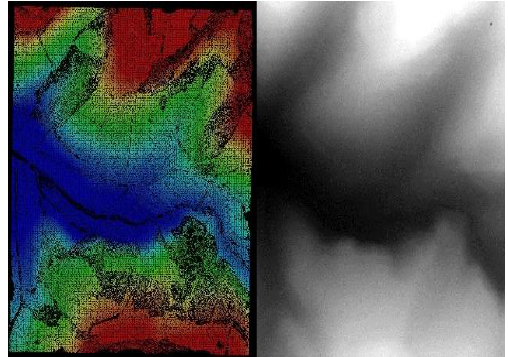
Figure 6. Filtered LiDAR data and generated DEM for F21